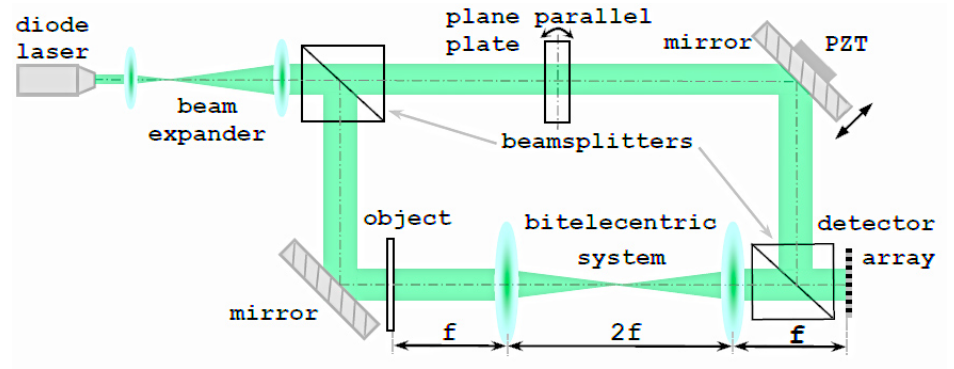
Figure 4. Experimental